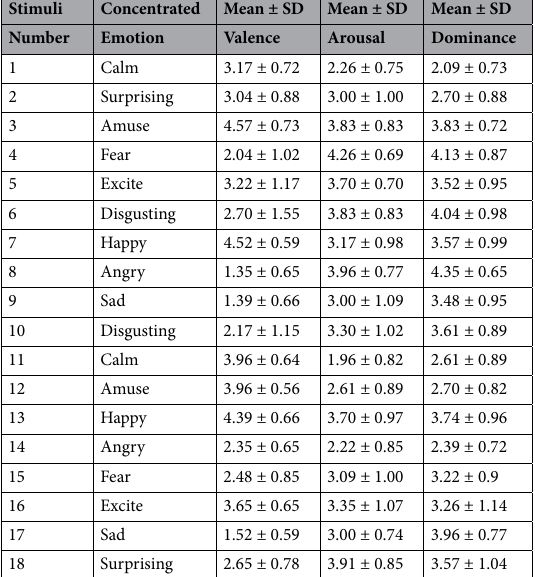
Table 3. Mean and standard deviation of self assessment ratings of arousal, valence and dominance.